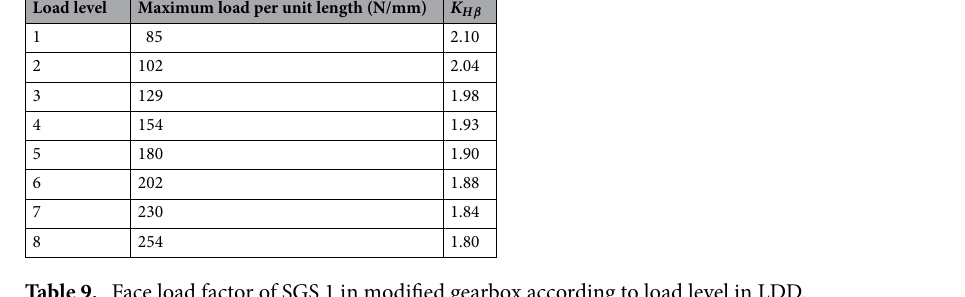
Table 9. Face load factor of SGS 1 in modified gearbox according to load level in LDD.